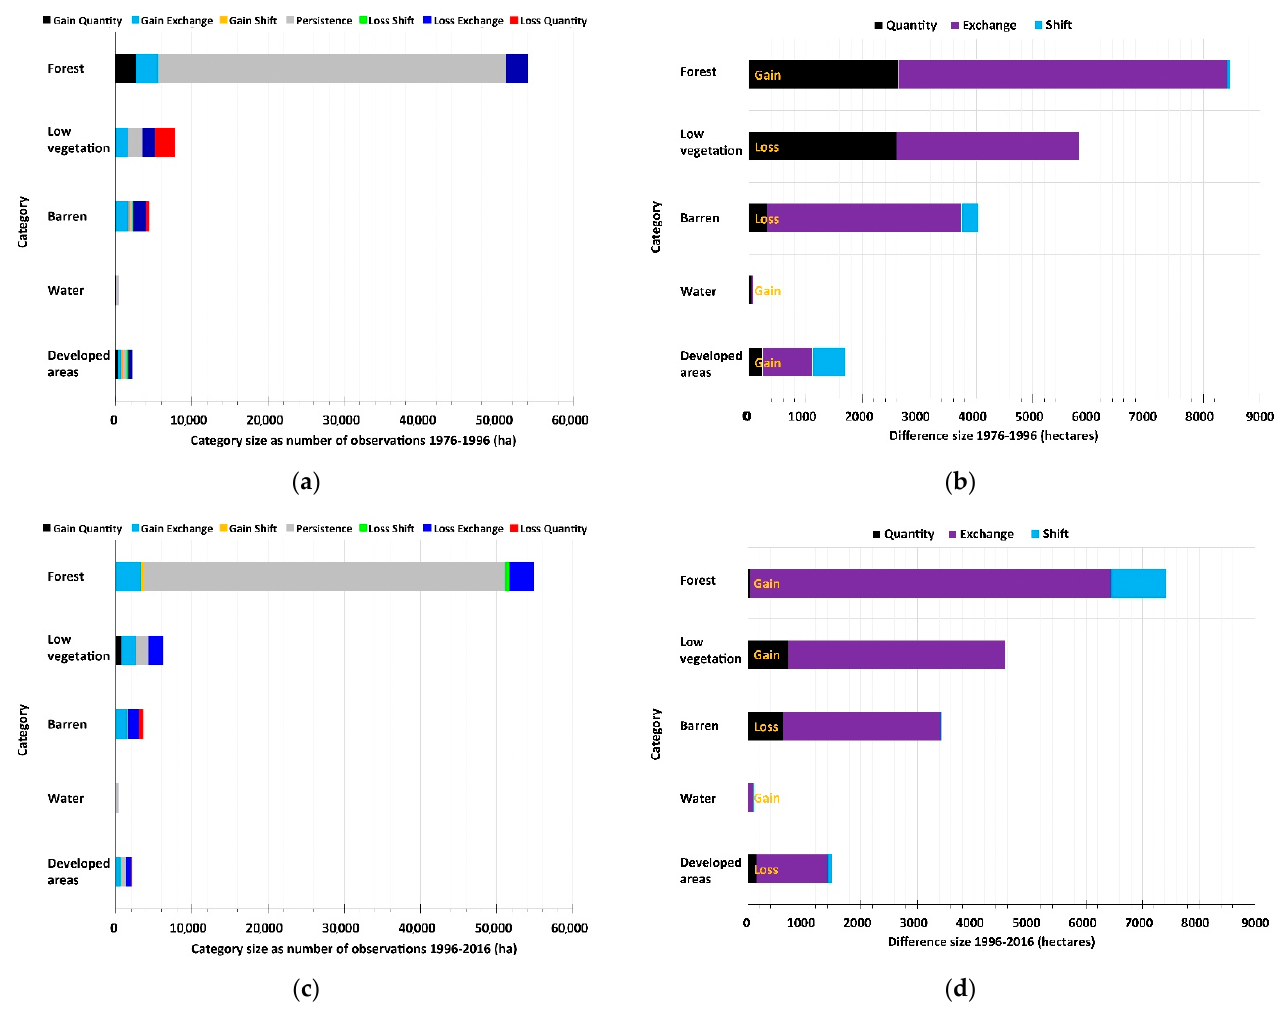
Figure 11. ( a ) Category size changes 1976–1996; ( b ) difference size changes 1976–1996; ( c ) category size changes 1996–2016; ( d ) difference size changes 1996–2016. Sizes are in ha.